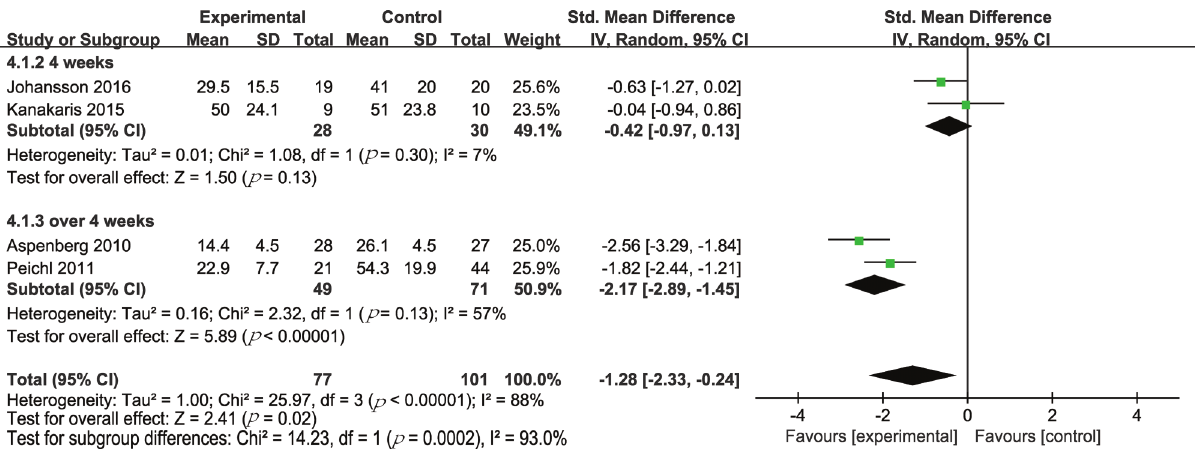
SMD, standardized mean difference.